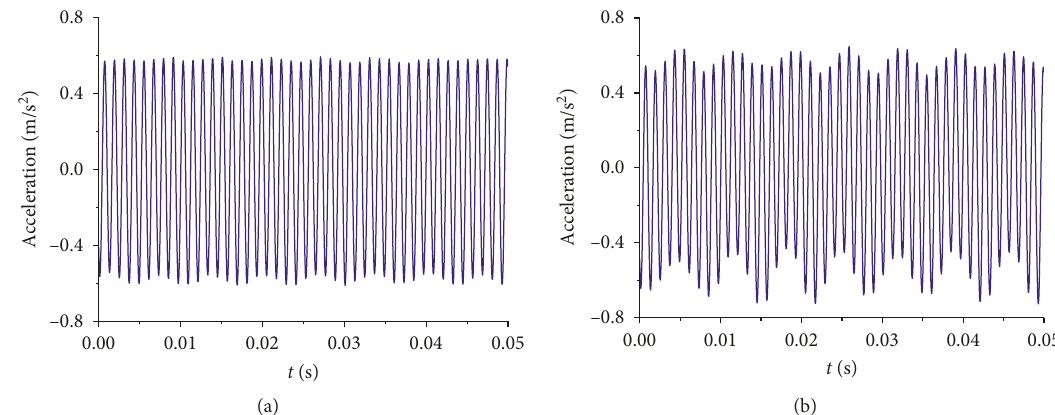
Figure 9: Time domain diagram of vertical vibration acceleration of bogie: (a) health gear (b) the crack length of the pinion is 4mm.